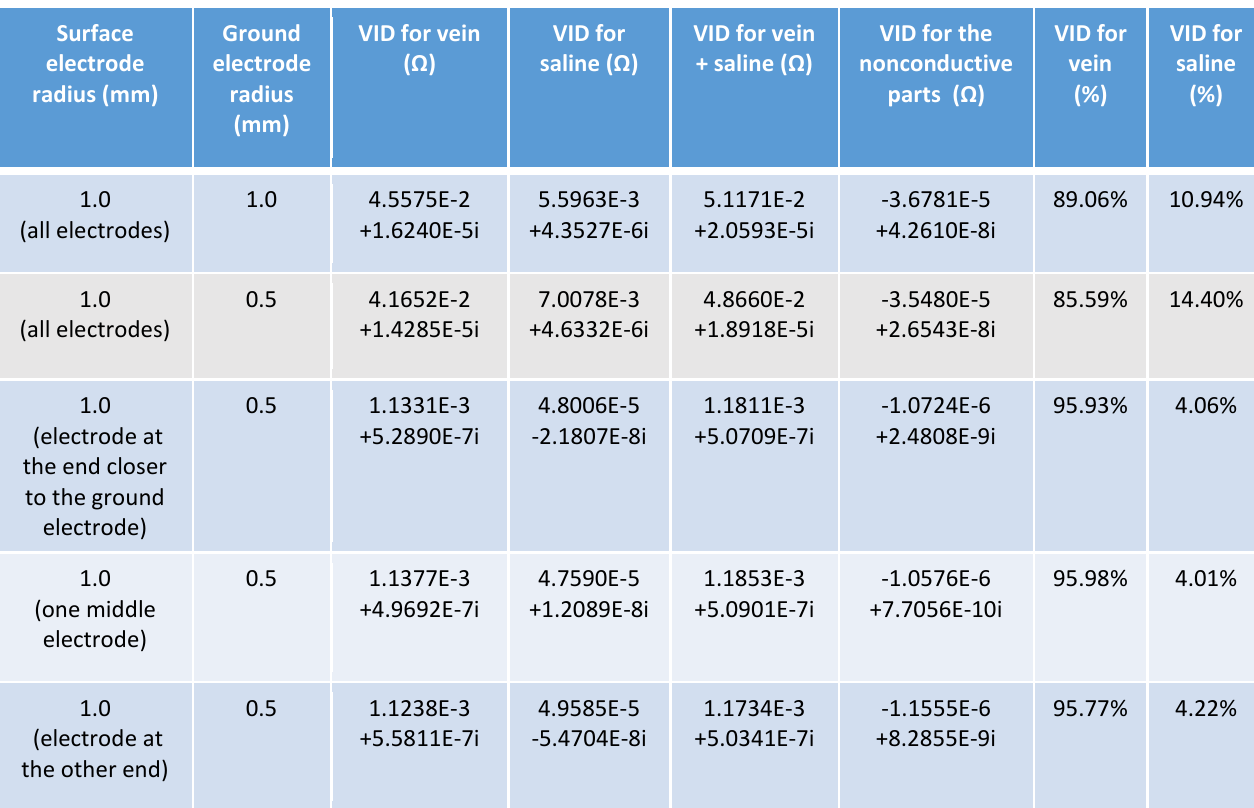
Table.18: Volume integration of Volume Impedance Density (VID) measurements at 1MHz with both all and one of the 48 surface electrodes as terminal (12 electrodes in 4 rows)